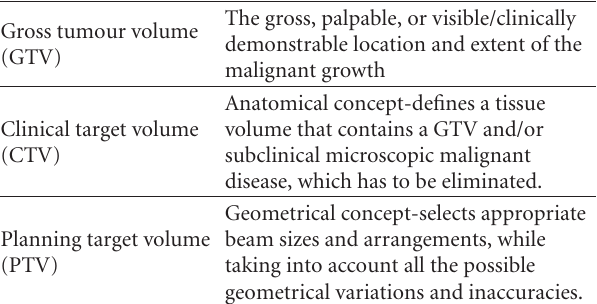
Table 1: Definition of volumes in